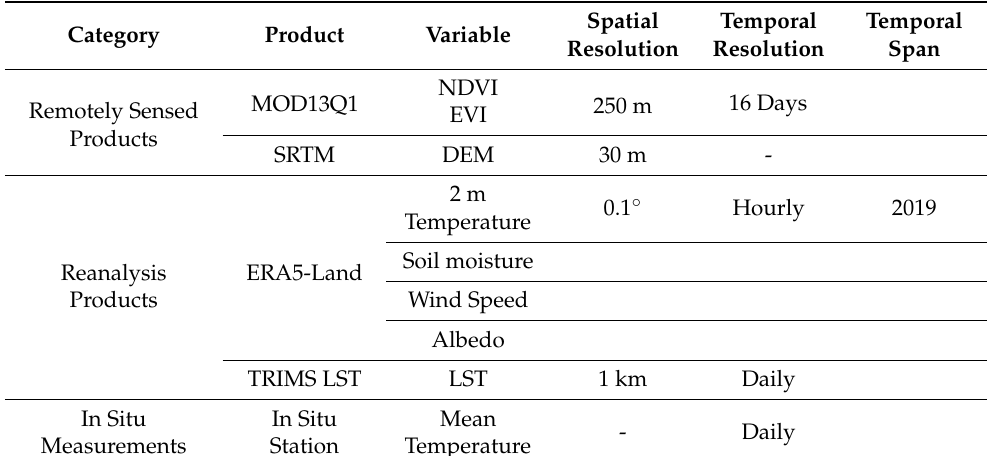
Table 1. Detailed information of three categories of datasets used in this study.